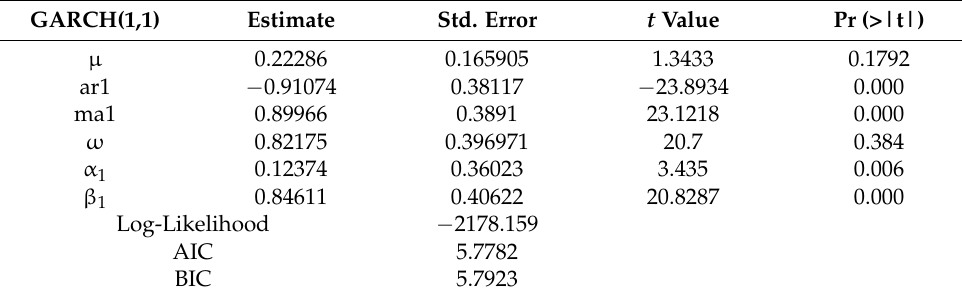
Table 3. Generalized autoregressive conditional heteroskedasticity (GARCH) (1,1) model.